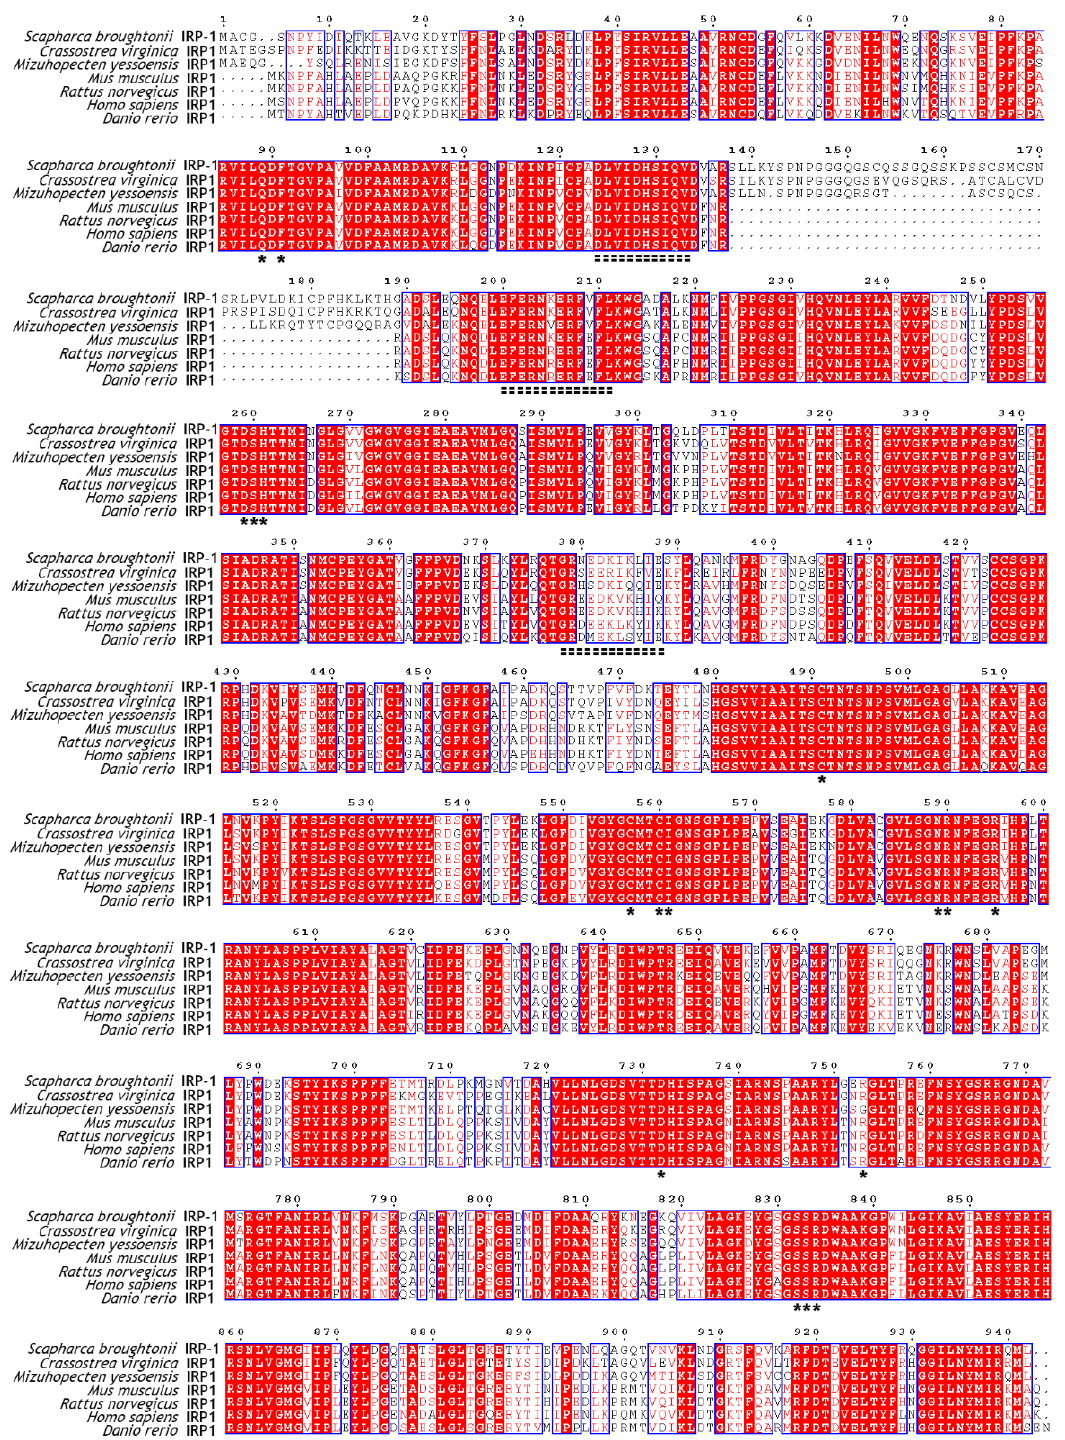
Figure 2. Multiple sequence alignment of Sb IRP-1 with other IRP1s from various species. The amino acid number above the sequence refers to Sb IRP-1. Asterisks represent active sites in the aconitase domains. The dashed amino acid fragments indicate putative RNA binding regions. Red shading re- gions indicate similar (consensus >70%) amino acids. The species (access number) include Crassostrea virginica (XP_022311890.1), Mizuhopecten yessoensis (XP_021340677.1), Mus musculus (NP_031412.2), Rattus norvegicus (NP_059017.2), Homo sapiens (NP_001265281.1), Danio rerio